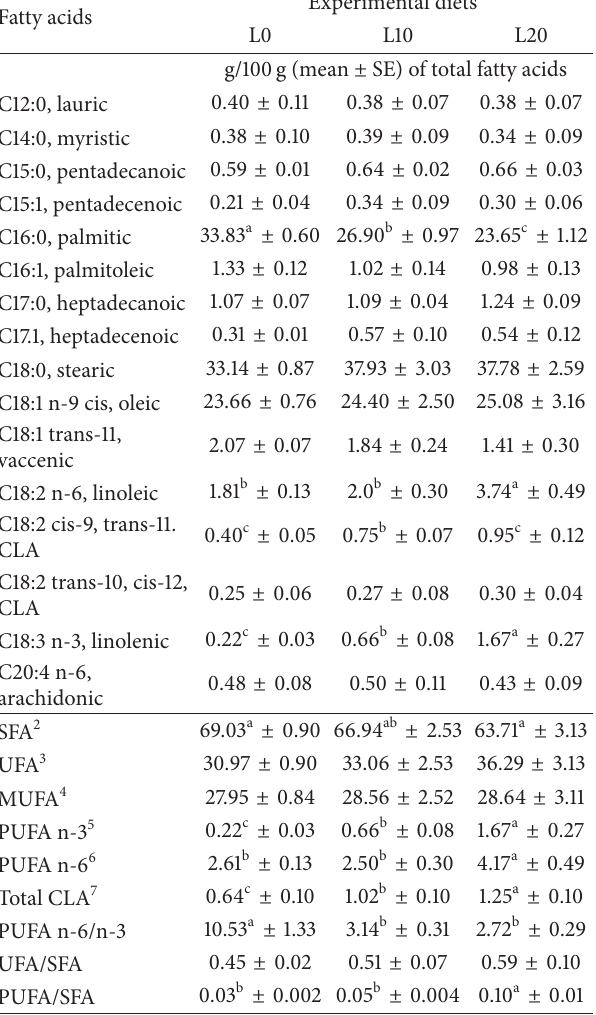
Table 7: Fatty acid profiles of perirenal fat of goats fed diets containing different levels of whole linseed.